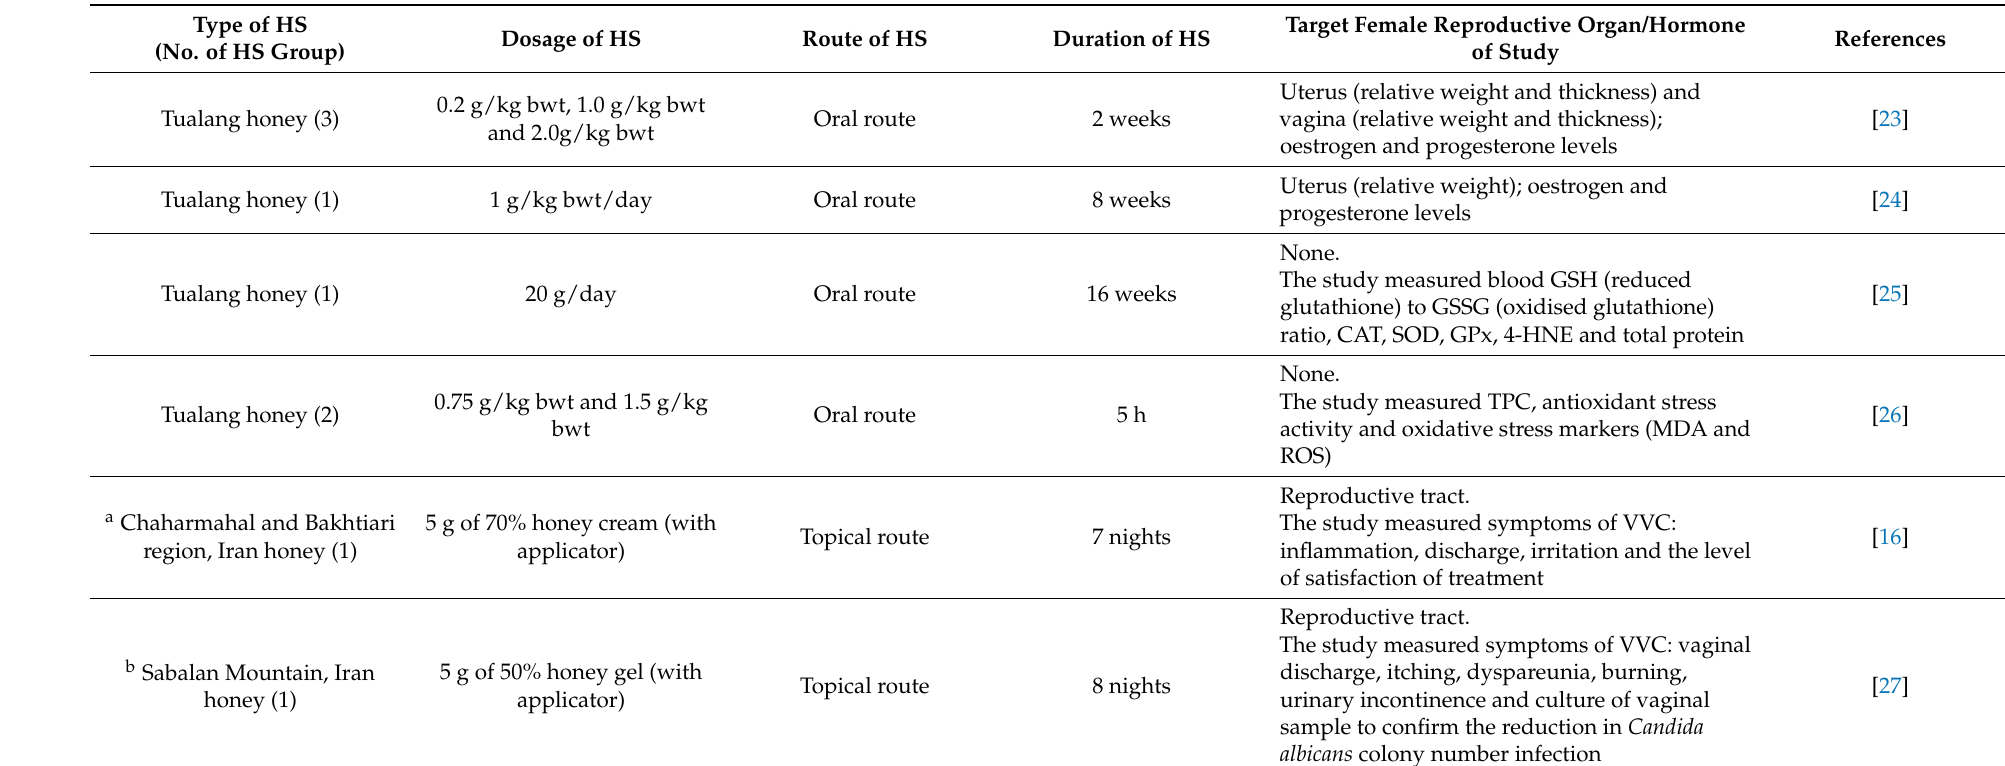
Table 1. Intervention characteristics of honey